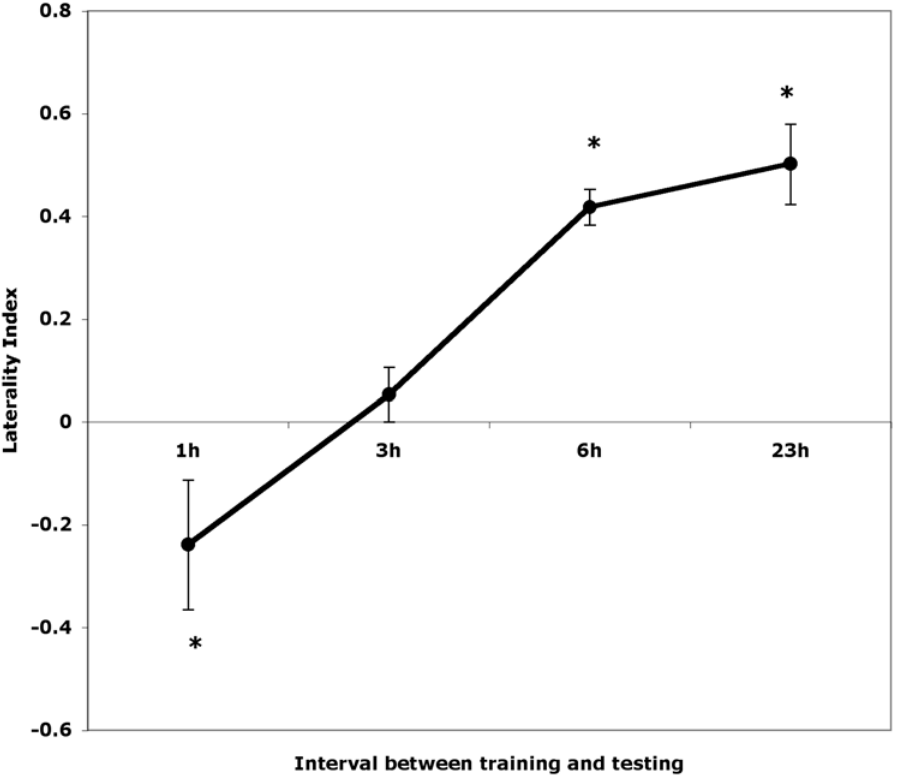
Figure 4. Experiment 2: The laterality Index is plotted as means + standard errors at different intervals after training. Asterisks indicate significant divergence from no bias. Note the shift from a right side bias at 1 hour to a left side bias at 6 and 23 hours. The LI scores were analysed by ANOVA using time of testing as a factor. A significant effect of time of testing was found (F 3,25 =16.769, p=0.0001). Post hoc LSD tests showed that the LI scores at 1 hour after training differed significantly from those at 3 hours (p=0.046), 6 hours (p=0.0001) and 23 hours (p=0.0001). The LI at 1 hour was biased to the right side, whereas at 6 and 23 hours the bias was to the left side and the same at both times (p=0.473). At 3 hours after training the LI had no significant bias as responding was equal on both sides and differed significantly from LI at 6 hours (p=0.007) and 23 hours (p=0.0001).